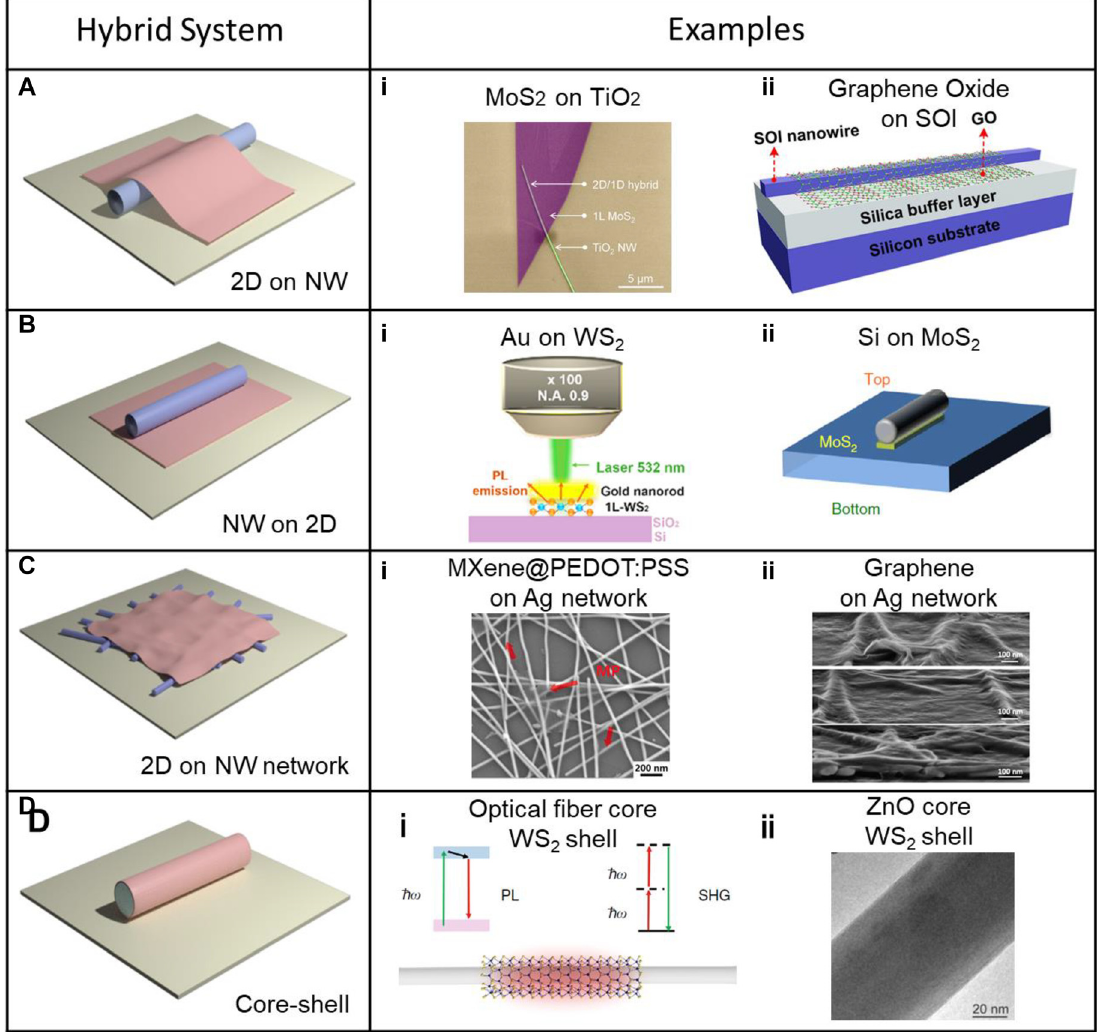
Figure 1: Schematic of the hybridization of nanowires and 2D materials. (A) 3D structure diagram of a 2D on a nanowire. (A-i) False-color SEM image of a monolayer MoS 2 /NW hybrid structure.